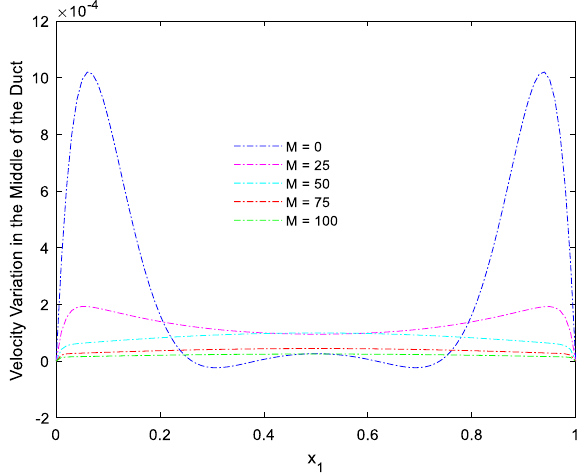
Figure 19. Velocity variation along the line x 2 = 0.5 for Ra = 100,000 and different M.